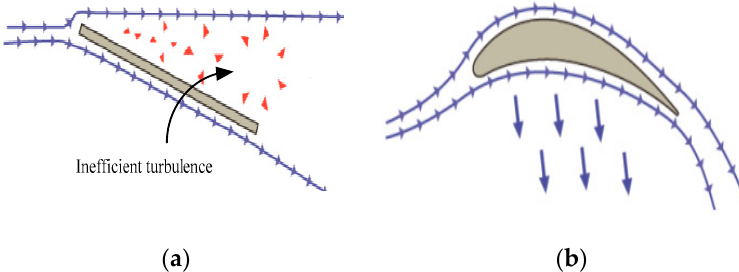
Figure 3. Technology of monstrous fan blades profile ( a ) Flat shape concept; ( b ) Air foil shape.